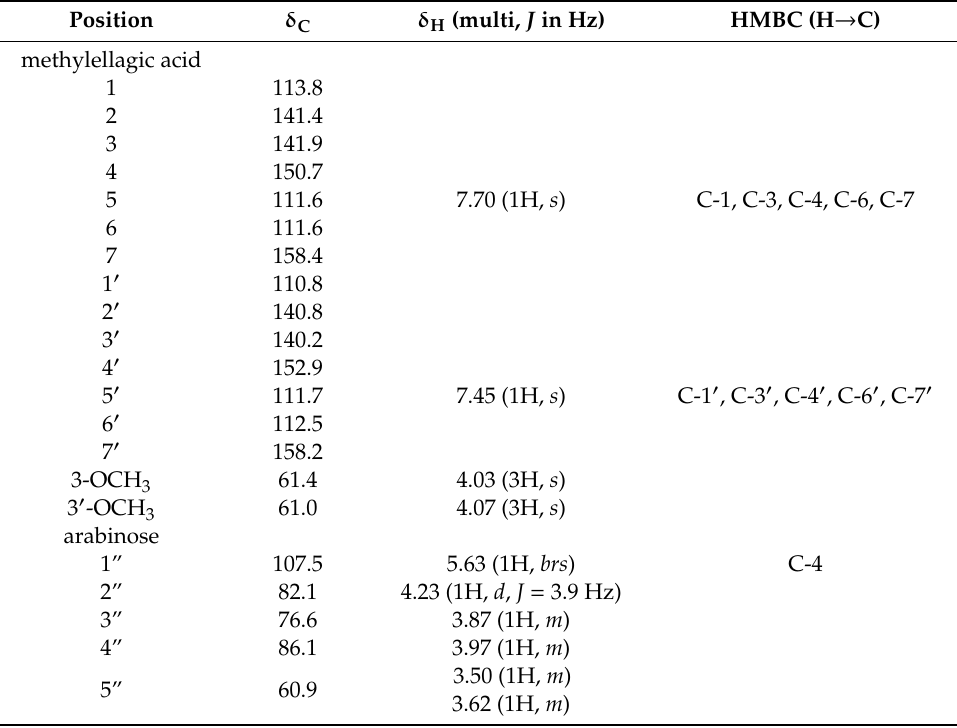
Table 1. 1 H-NMR and 13 C-NMR spectral data of 1 ( δ values, in DMSO- d 6 , J in